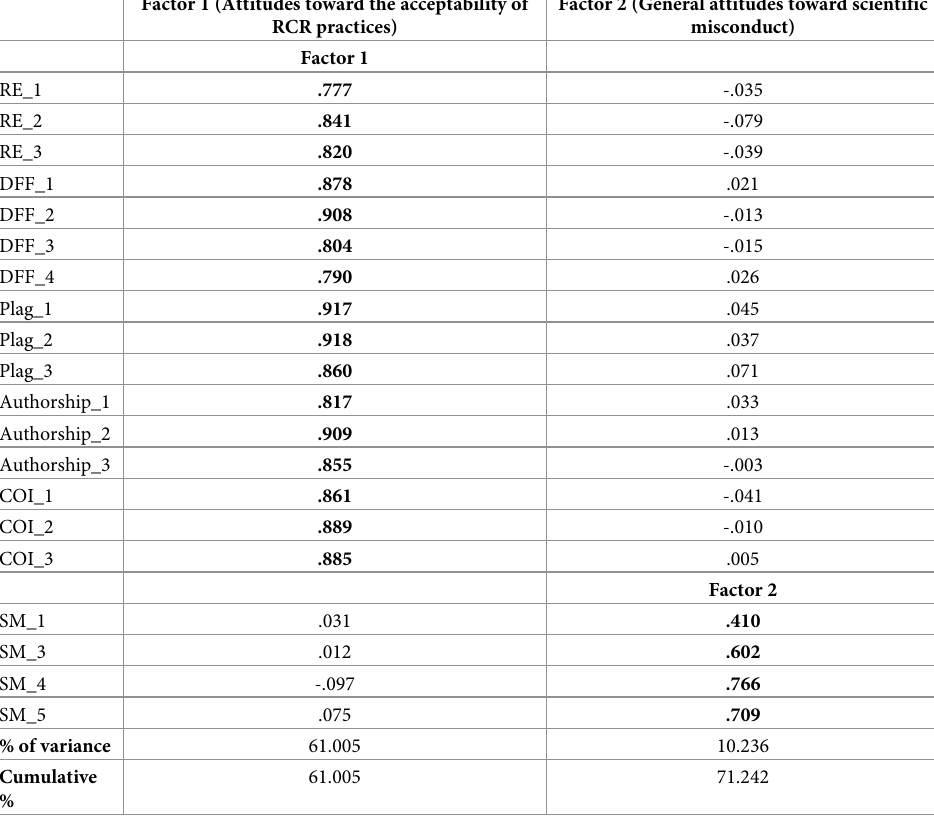
Table 5. Factor loadings of the different items of the attitude scales: “Attitudes toward the acceptability of RCR practices” and “general attitude toward scientific